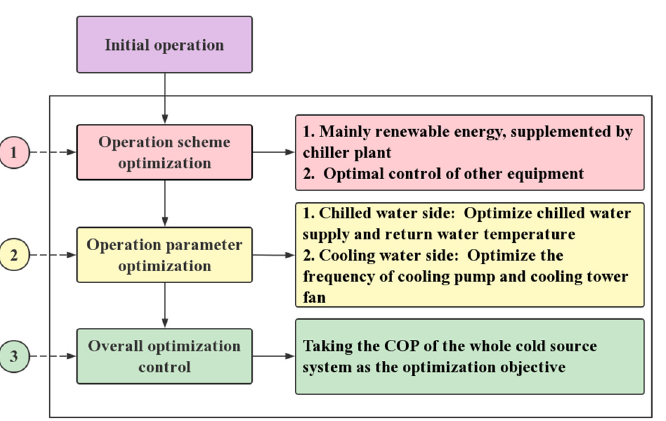
Figure 1. Cooperative optimization method for multi-chiller plant cooling system.